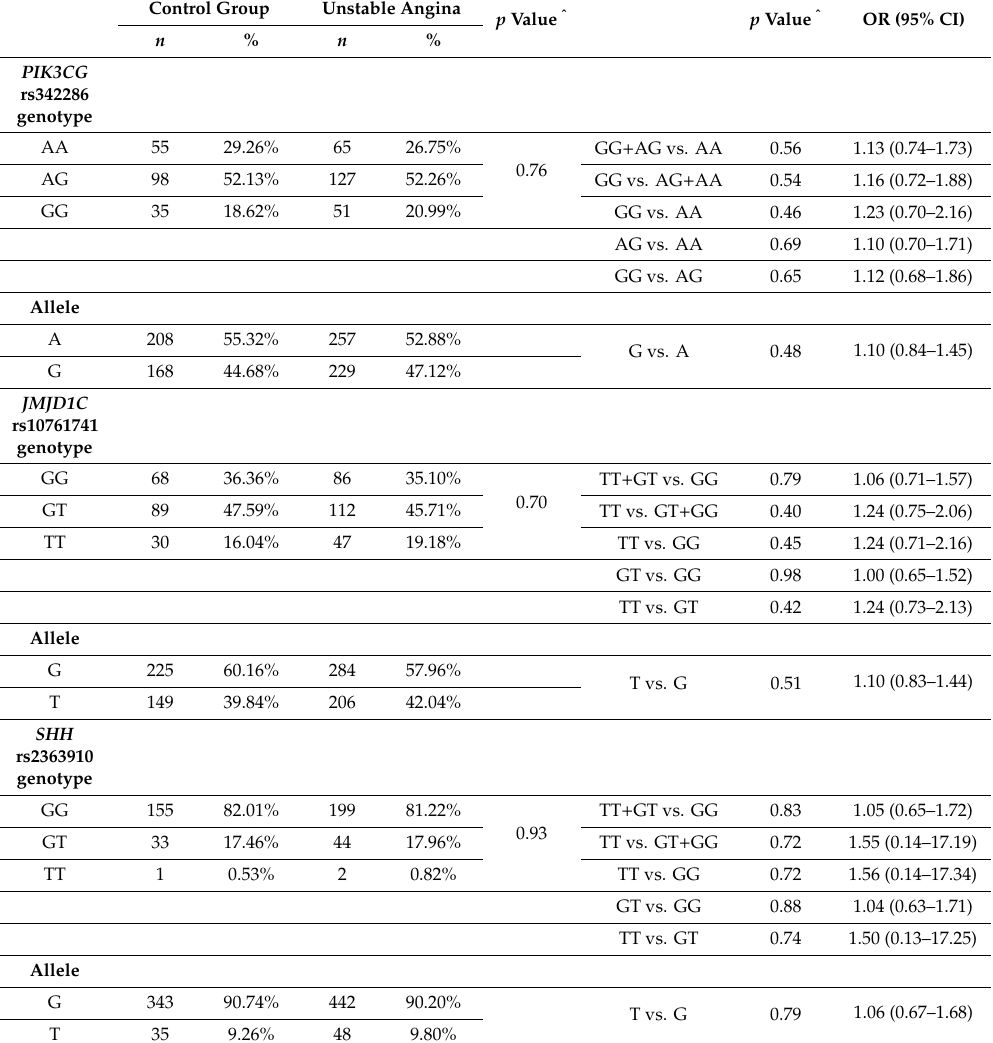
Table 2. Distributions of the PIK3CG , JMJD1C , and SHH genotypes and alleles in patients with unstable angina and controls.